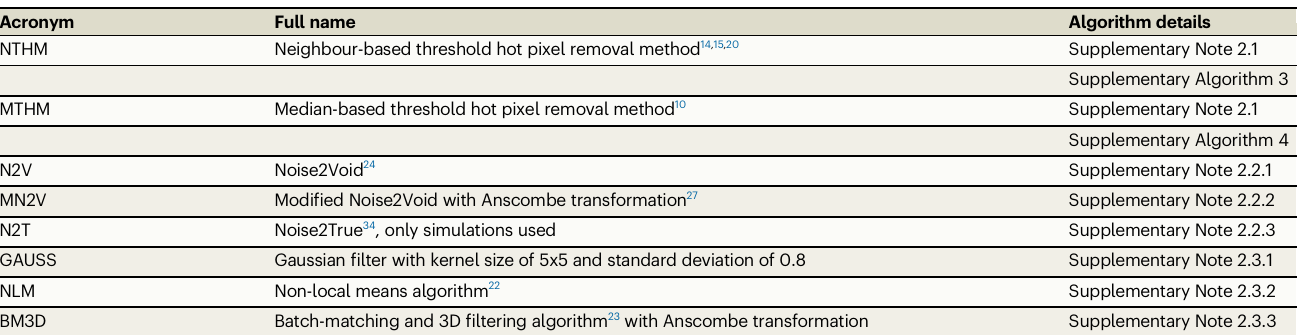
Table 1 | Reference denoising algorithm